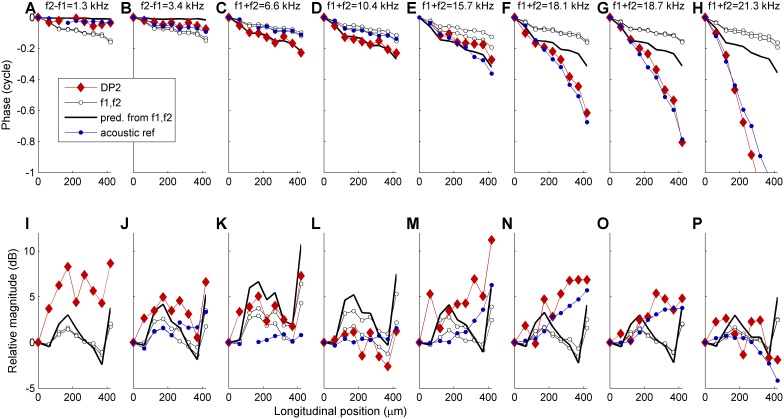
Propagation of DP2s in the 18-25-kHz region.Recordings were made at 9 adjacent longitudinal locations spanning ~400 μm. Phase (upper row) and magnitude (lower row) are shown of: 6 example DP2 components (red diamonds); its two parent primaries f1 and f2 (open black circles); phase and amplitude predicted by Equation 1, that is assuming local generation (black line); a reference acoustically presented component of approximately the same frequency (blue circles). DP frequency is indicated above each phase graph. For the lowest DP2 frequencies (1.3-10.4 kHz) the actual DP2 phase matches the prediction within ~0.05 cycle. For the higher DP2 frequencies systematic deviations occur. The phase accumulation of the high-frequency DP2s matches the phase of the acoustic reference much better than the prediction based on local generation. Thus these high-frequency DP2 components are dominated by their own propagation rather than local contributions from the primaries as in Equation 1. The increasing dominance of propagation with increasing DP2 frequency was observed for all DP2s.